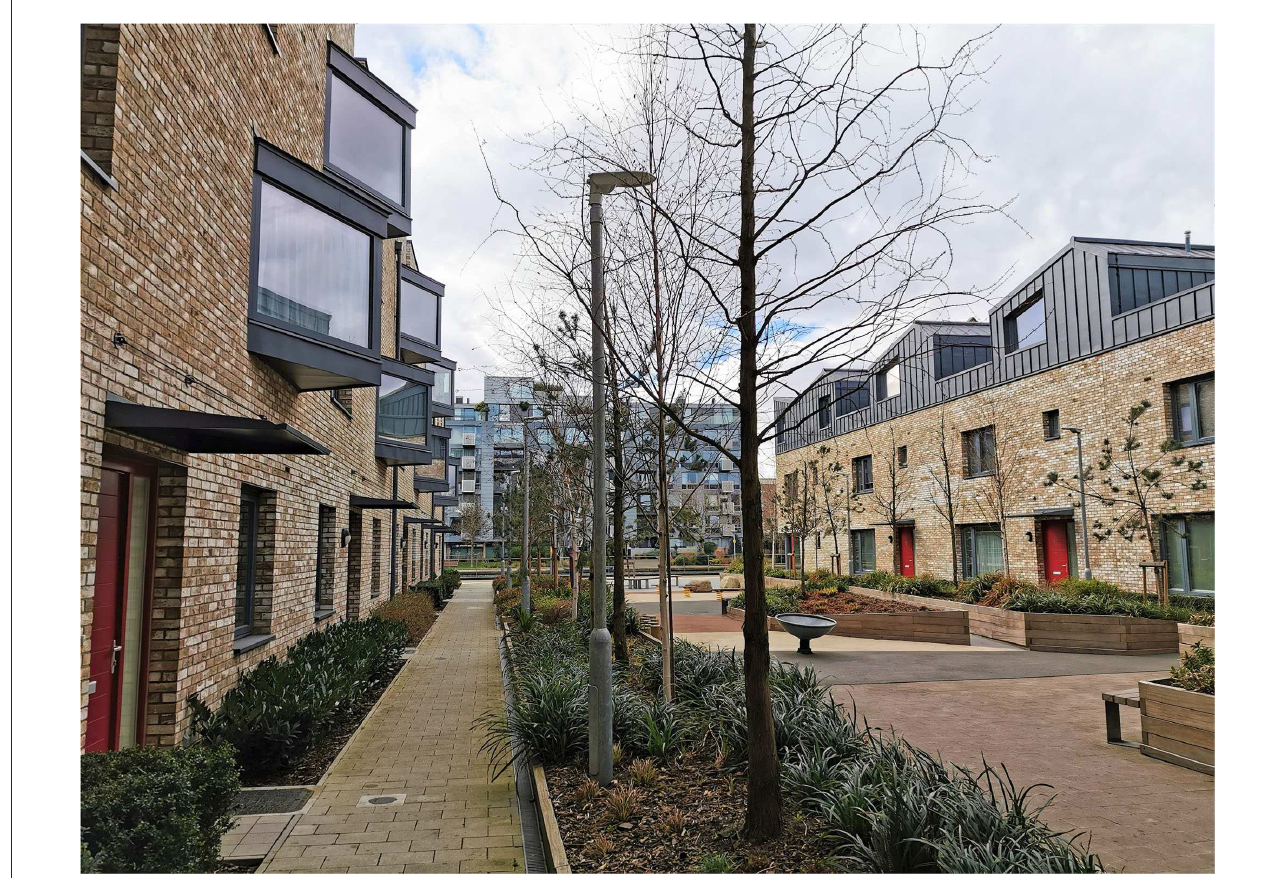
FIGURE10 View of shared space at Wharf